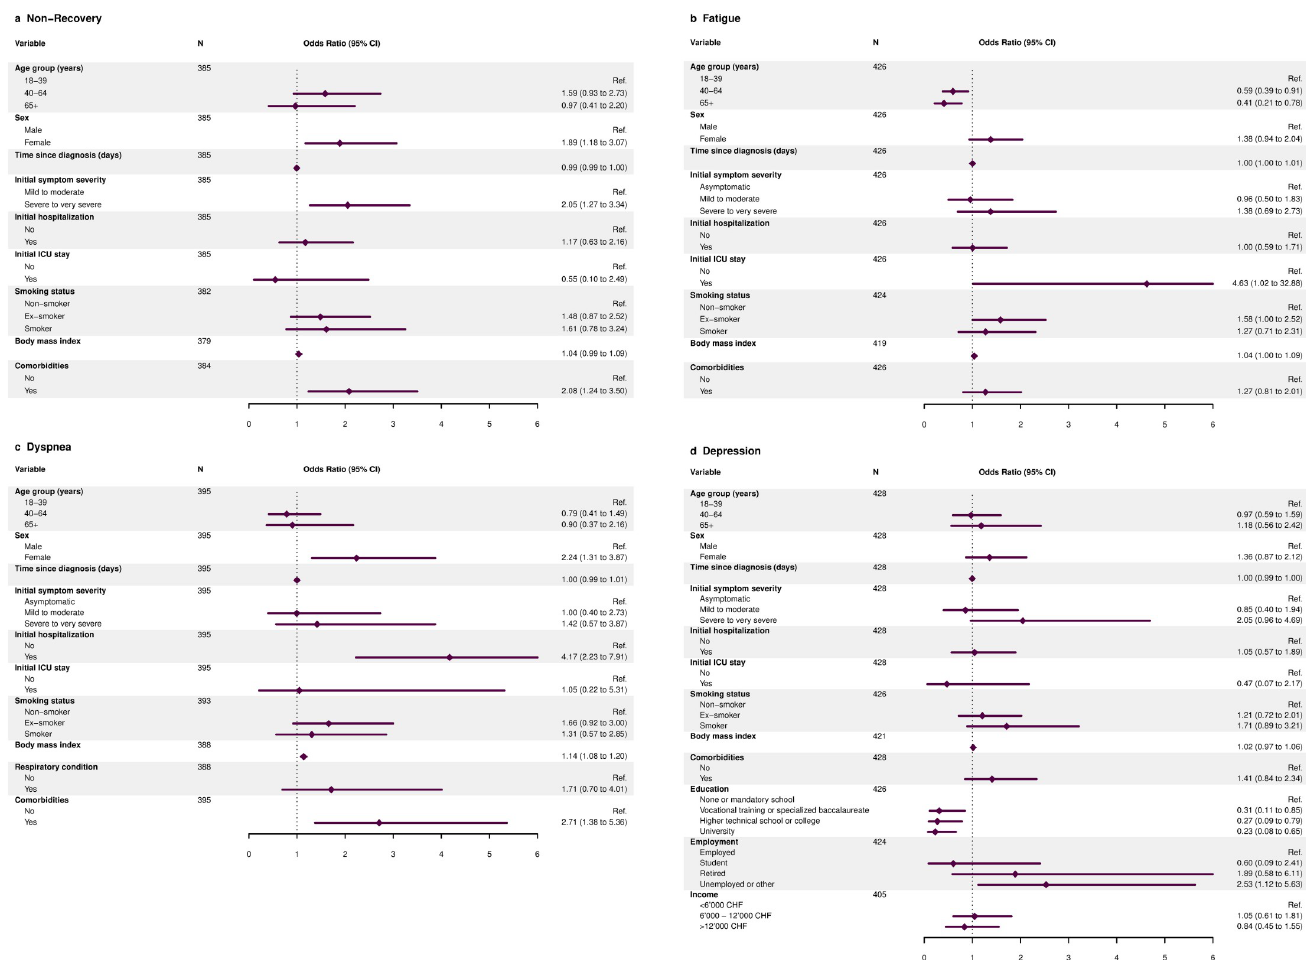
Fig 2. Associations for non-recovery, fatigue, dyspnea and depression at six to eight months after SARS-CoV-2 infection. Panel (a) shows associations for not having fully recovered among initially symptomatic participants from multivariable logistic regression models adjusted for age, sex, initial hospitalization, symptom severity and presence of comorbidities. Panel (b) demonstrates associations for presence of fatigue (based on Fatigue Assessment Scale) from models adjusted for age, sex, and initial hospitalization. Panel (c) displays associations for presence of dyspnea (mMRC grade � 1) from models adjusted for age, sex, initial hospitalization, smoking status, respiratory comorbidity and body mass index. Panel (d) shows associations for presence of depressive symptoms (based on DASS-21) from models adjusted for age, sex, initial hospitalization and symptom severity.